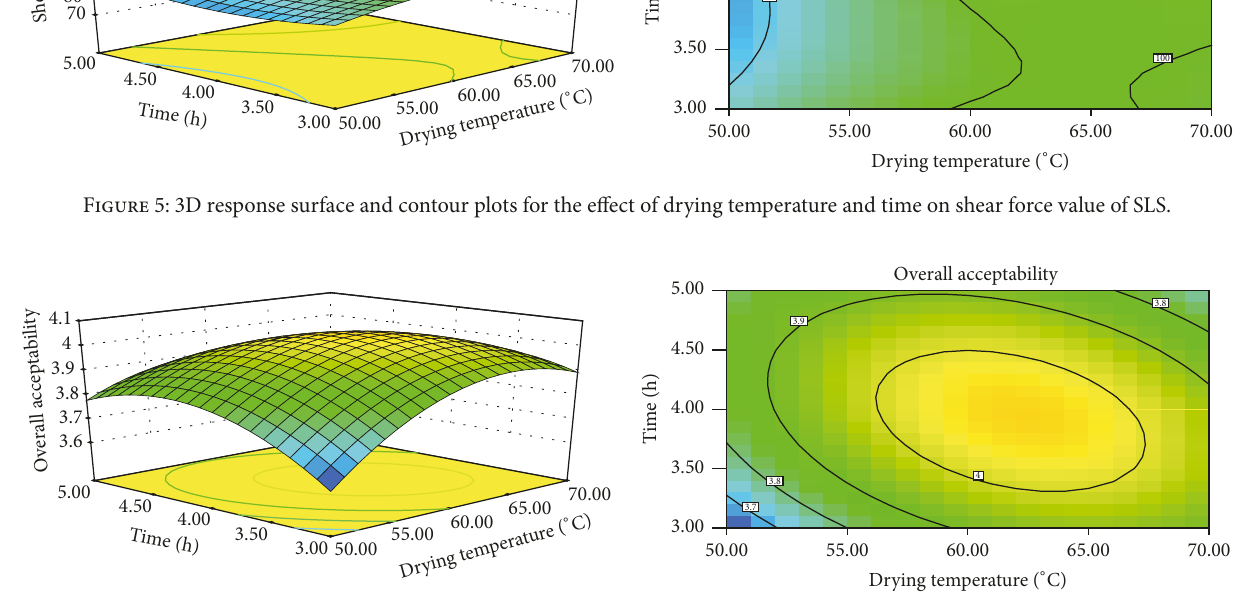
Figure 6: 3D response surface and contour plots for the effect of drying temperature and time on overall acceptability value of